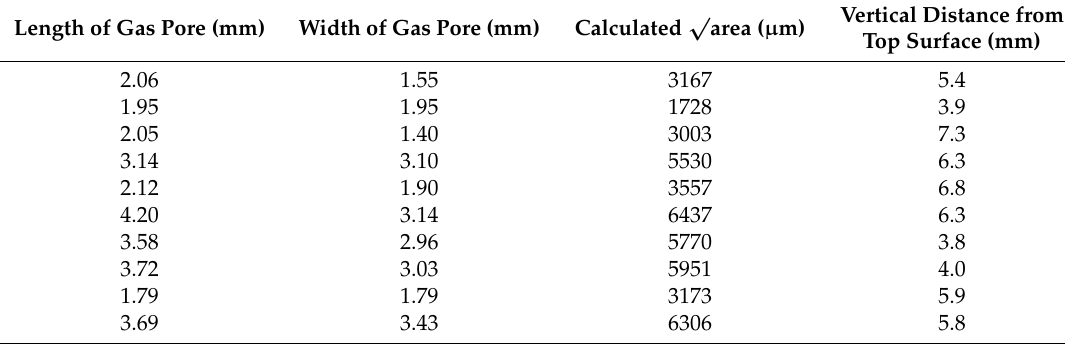
Table 5. Measured pore sizes and positions for test series √area > 1000 µm.